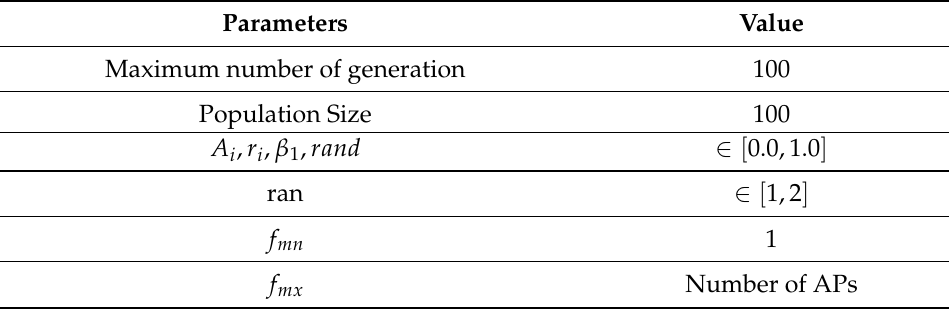
Table 2. BDPP parameters.